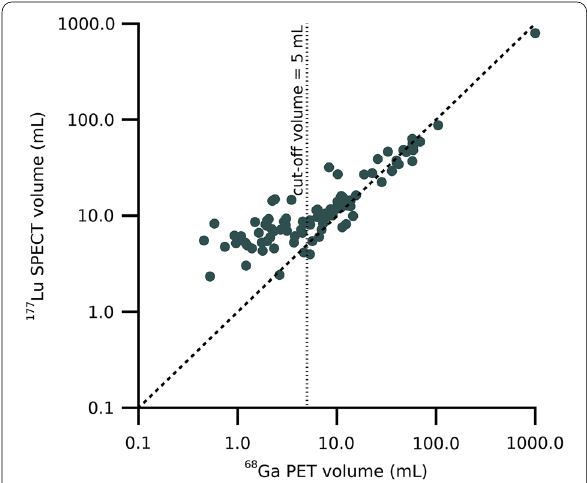
Fig. 1 Tumour volumes estimated from 68 Ga-PET and 177 Lu-SPECT. The dashed line indicates the identity line, and the vertical dotted line indicates the volume cutoff of 5 mL employed in the